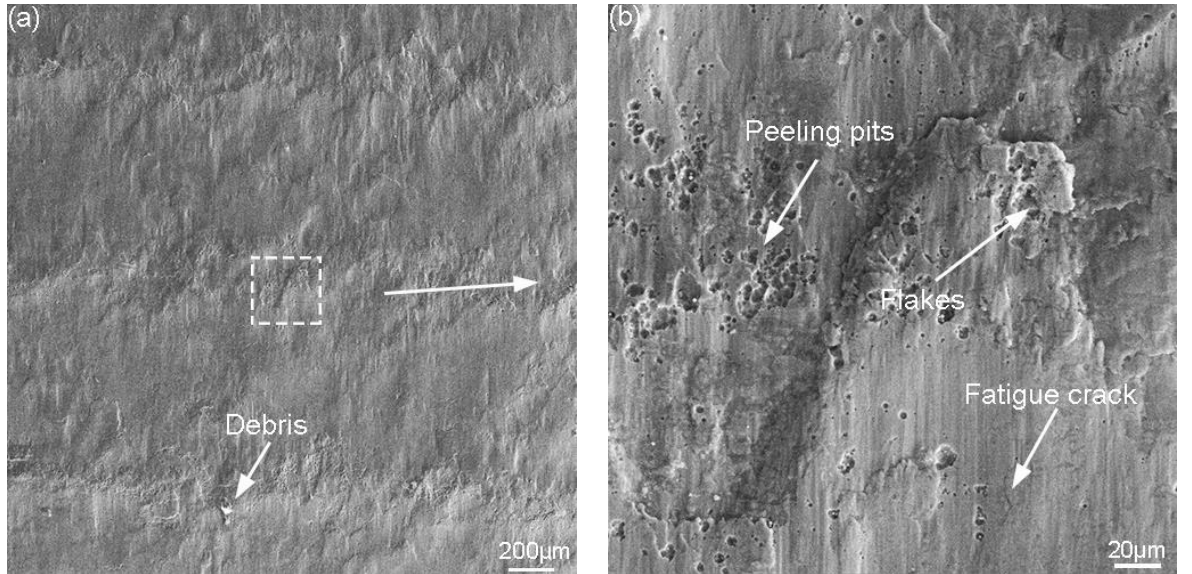
Figure 3. SEM image of the wear surface of test steel: ( a ) debris and ( b ) peeling pits and cracks.